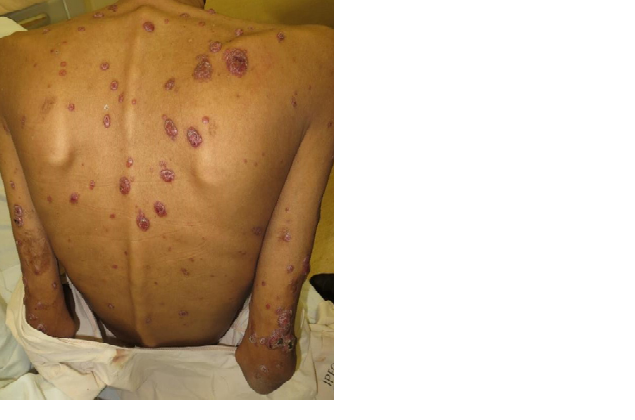
Figure 1. Disseminated cutaneous sporotrichosis: nodular ulcerative lesions on the trunk and arms. HIV infection was the most prevalent cause of immunosuppression, being present in 42 (79.2%) participants. Among the 53 patients, 17 showed neurological symptoms or signs of meningitis (Group 1) while 36 did not (Group 2). Epidemiological, clinical, and laboratory findings in the two groups are described in Table